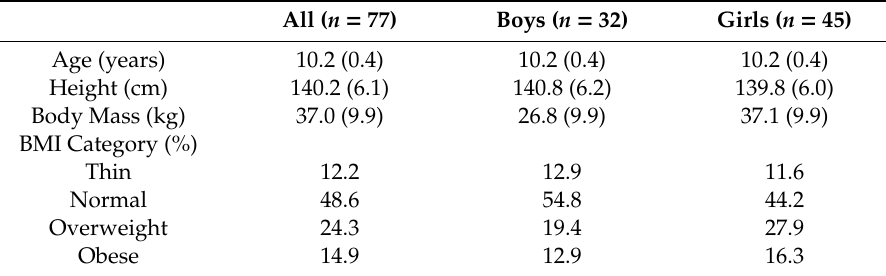
Table 1. Child participant characteristics.